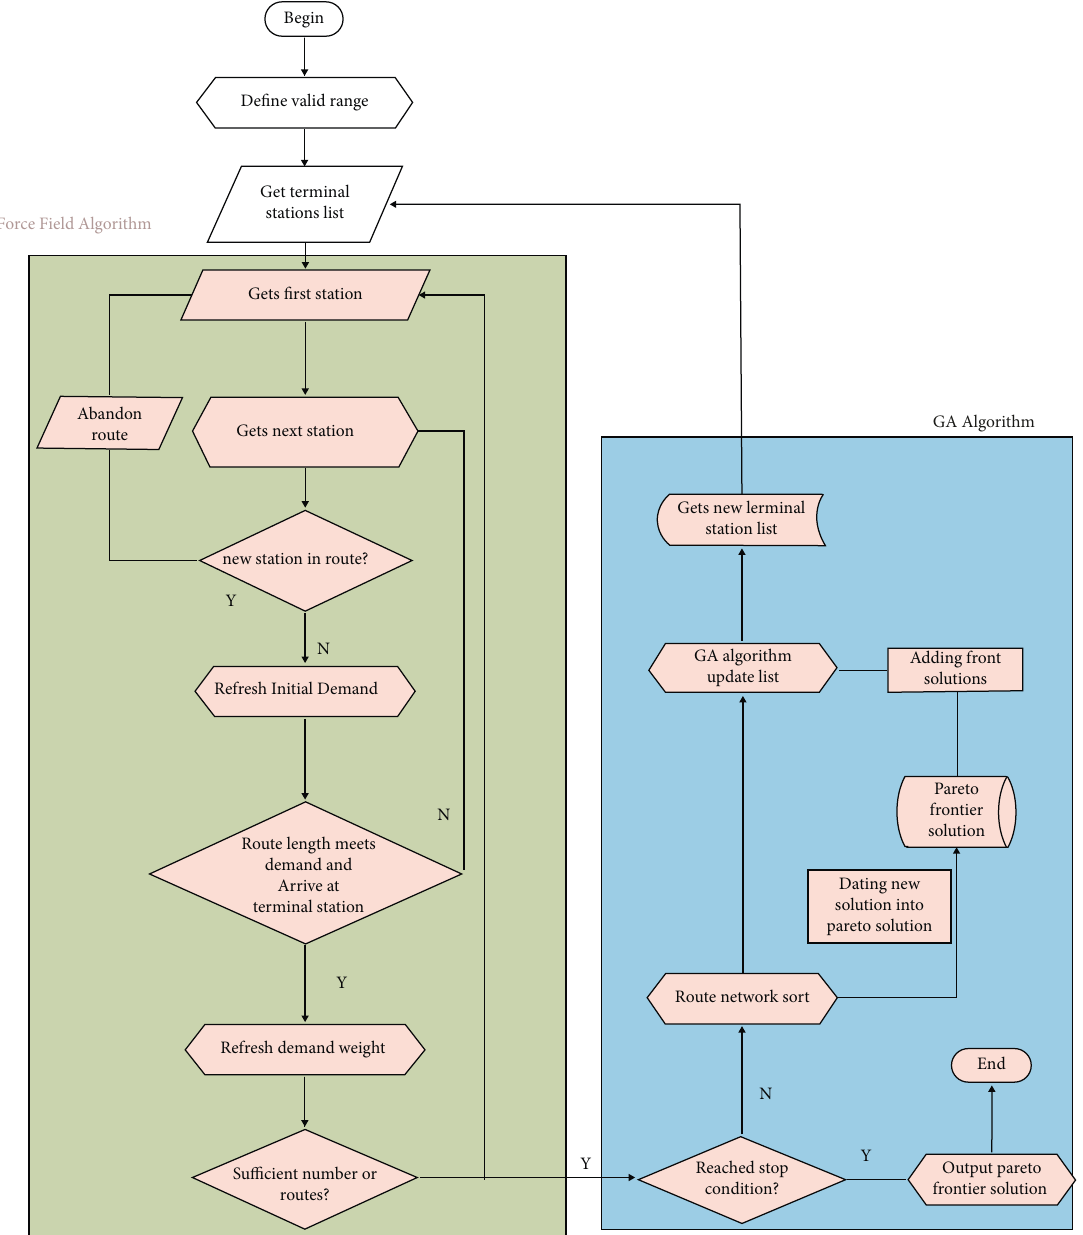
Figure 1: The entire process of route generation and